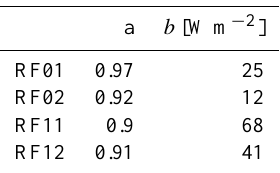
Table 2. Regression values used to correct the pyranometer irradi- ance Q pyr − adj = a · Q pyr + b .